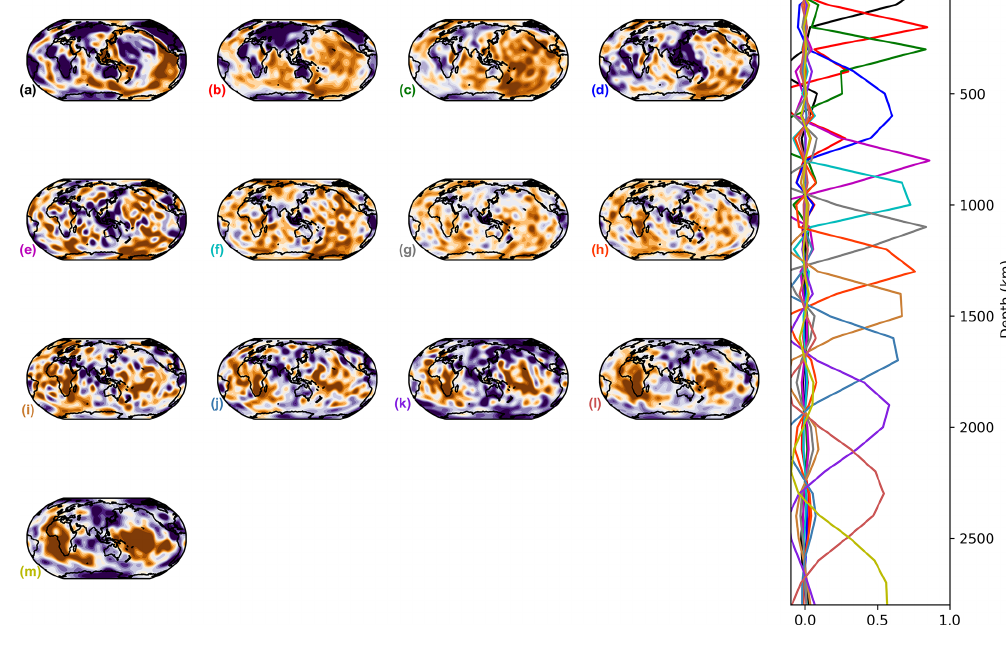
Figure C3. The 13 varimax components of the S20RTS model.